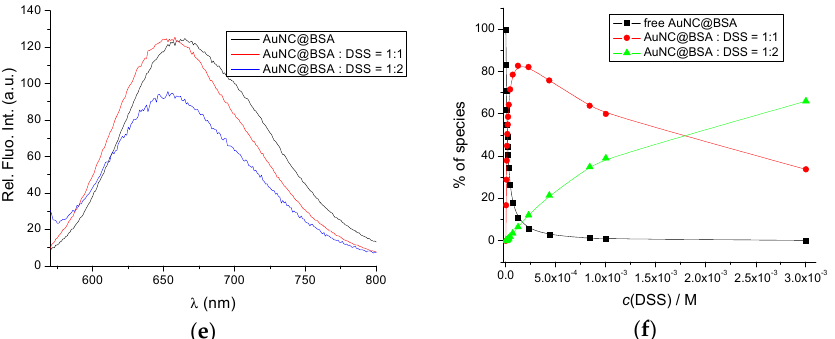
Figure 3. ( a ) Fluorescent emission spectra of AuNC@BSA ( c (BSA, AuNC@BSA) = 0.952 μ M or c (Au 25 , AuNC@BSA) = 0.505 μ M in a cuvette) upon titration with DSS in water ( λ exc = 365 nm, S exc = 20, S em = 20) at 298 K; ( b ) Emission dependence of AuNC@BSA on c (DSS) at λ max = 655 nm; ( c ) Fluorescent emission spectra of AuNC@BSA (( c (BSA, AuNC@BSA) = 0.952 μ M or c (Au 25 , AuNC@BSA) = 0.505 μ M in a cuvette) upon titration with DSS in water ( λ exc = 540 nm) at 298 K; ( d ) Fitting the titration